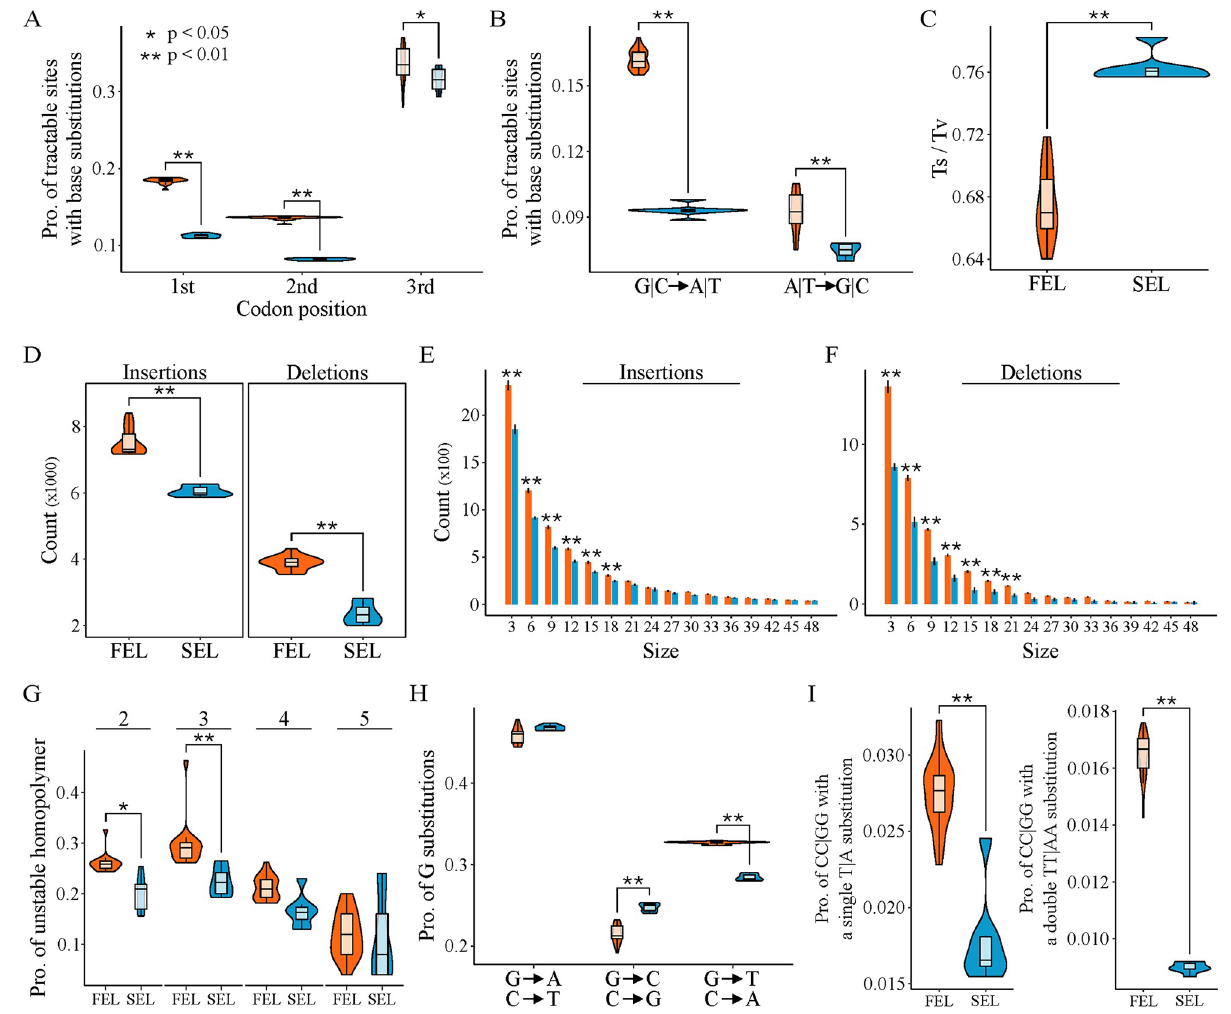
Fig 6. Analyses of base substitutions and indels reveal a higher mutational load in the FEL compared to the SEL. (A) Analyses of substitution patterns among codon-based alignments of 1,034 OGs revealed a higher number of base substitutions in the FEL compared to the SEL (F(1) = 196.88, p < 0.001; multifactor ANOVA) and an asymmetric distribution of base substitutions at codon sites (F(2) = 1,691.60, p < 0.001; multifactor ANOVA). A Tukey honest significance differences post hoc test revealed a higher proportion of substitutions in the FEL compared to the SEL at the first ( n = 240,565; p < 0.001), second ( n = 318,987; p < 0.001), and third ( n = 58,151; p = 0.02) codon positions. (B) Analyses of the direction of base substitutions (i.e., G|C ! A|T or A|T ! G|C) revealed significant differences between the FEL and SEL (F(1) = 447.1, p < 0.001; multifactor ANOVA) as well as differences in the directionality of base substitutions (F(1) = 914.5, p < 0.001; multifactor ANOVA). A Tukey honest significance differences post hoc test revealed a significantly higher proportion of substitutions were G|C ! A|T compared to A|T ! G|C among sites that are G|C ( n = 232,546) and A|T ( n = 385,157) ( p < 0.001), suggesting a general AT bias of base substitutions. Additionally, there was a significantly higher proportion of sites with base substitutions in the FEL compared to the SEL ( p < 0.001). Specifically, a higher number of base substitutions was observed in the FEL compared to the SEL for both G|C ! A|T ( p < 0.001) and A|T ! G|C mutations ( p < 0.001), but the bias toward AT was greater in the FEL. (C) Examinations of transition/transversion ratios revealed a lower transition/transversion ratio in the FEL compared to the SEL ( p < 0.001; Wilcoxon rank–sum test). (D) Comparisons of insertions and deletions revealed a significantly greater number of insertions ( p < 0.001; Wilcoxon rank–sum test) and deletions ( p < 0.001; Wilcoxon rank–sum test) in the FEL ( � X ¼ 7 ; 521 : 11 � 405 : 34 ; � X ¼ 3 ; 894 : 11 � 208 : 16 ) compared to the SEL insertions deletions ¼ 6 ; 049 : 571 � 155 : 85 ; � X ¼ 2 ; 346 : 71 � 326 : 22 ). (E and F) When adding the factor of size per insertion or deletion, significant ( � X insertions deletions differences were still observed between the lineages (F(1) = 2,102.87, p < 0.001; multifactor ANOVA). A Tukey honest significance differences post hoc test revealed that most differences were caused by significantly more small insertions and deletions in the FEL compared to the SEL. More specifically, there were significantly more insertions in the FEL compared to the SEL for sizes 3–18 ( p < 0.001 for all comparisons between each lineage for each insertion size), and there were significantly more deletions in the FEL compared to the SEL for sizes 3–21 ( p < 0.001 for all comparisons between each lineage for each deletion size). Black lines at the top of each bar show the 95% confidence interval for the number of insertions or deletions for a given size. (G) Evolutionarily conserved homopolymers of sequence length 2 ( n = 17,391), 3 ( n = 1,062), 4 ( n = 104), and 5 ( n = 5) were examined for substitutions and indels. Statistically significant differences of the proportion mutated bases (i.e., [base substitutions + deleted bases + inserted bases]/ total homopolymer bases) were observed between the FEL and SEL (F(1) = 27.68, p < 0.001; multifactor ANOVA). Although the FEL had